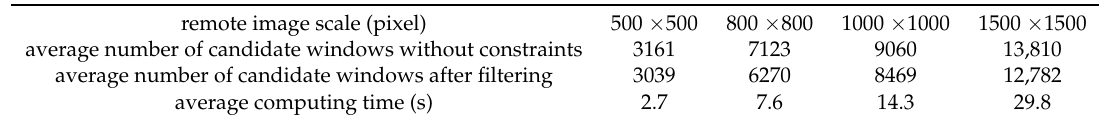
Table 2. The performance analysis for the selective search